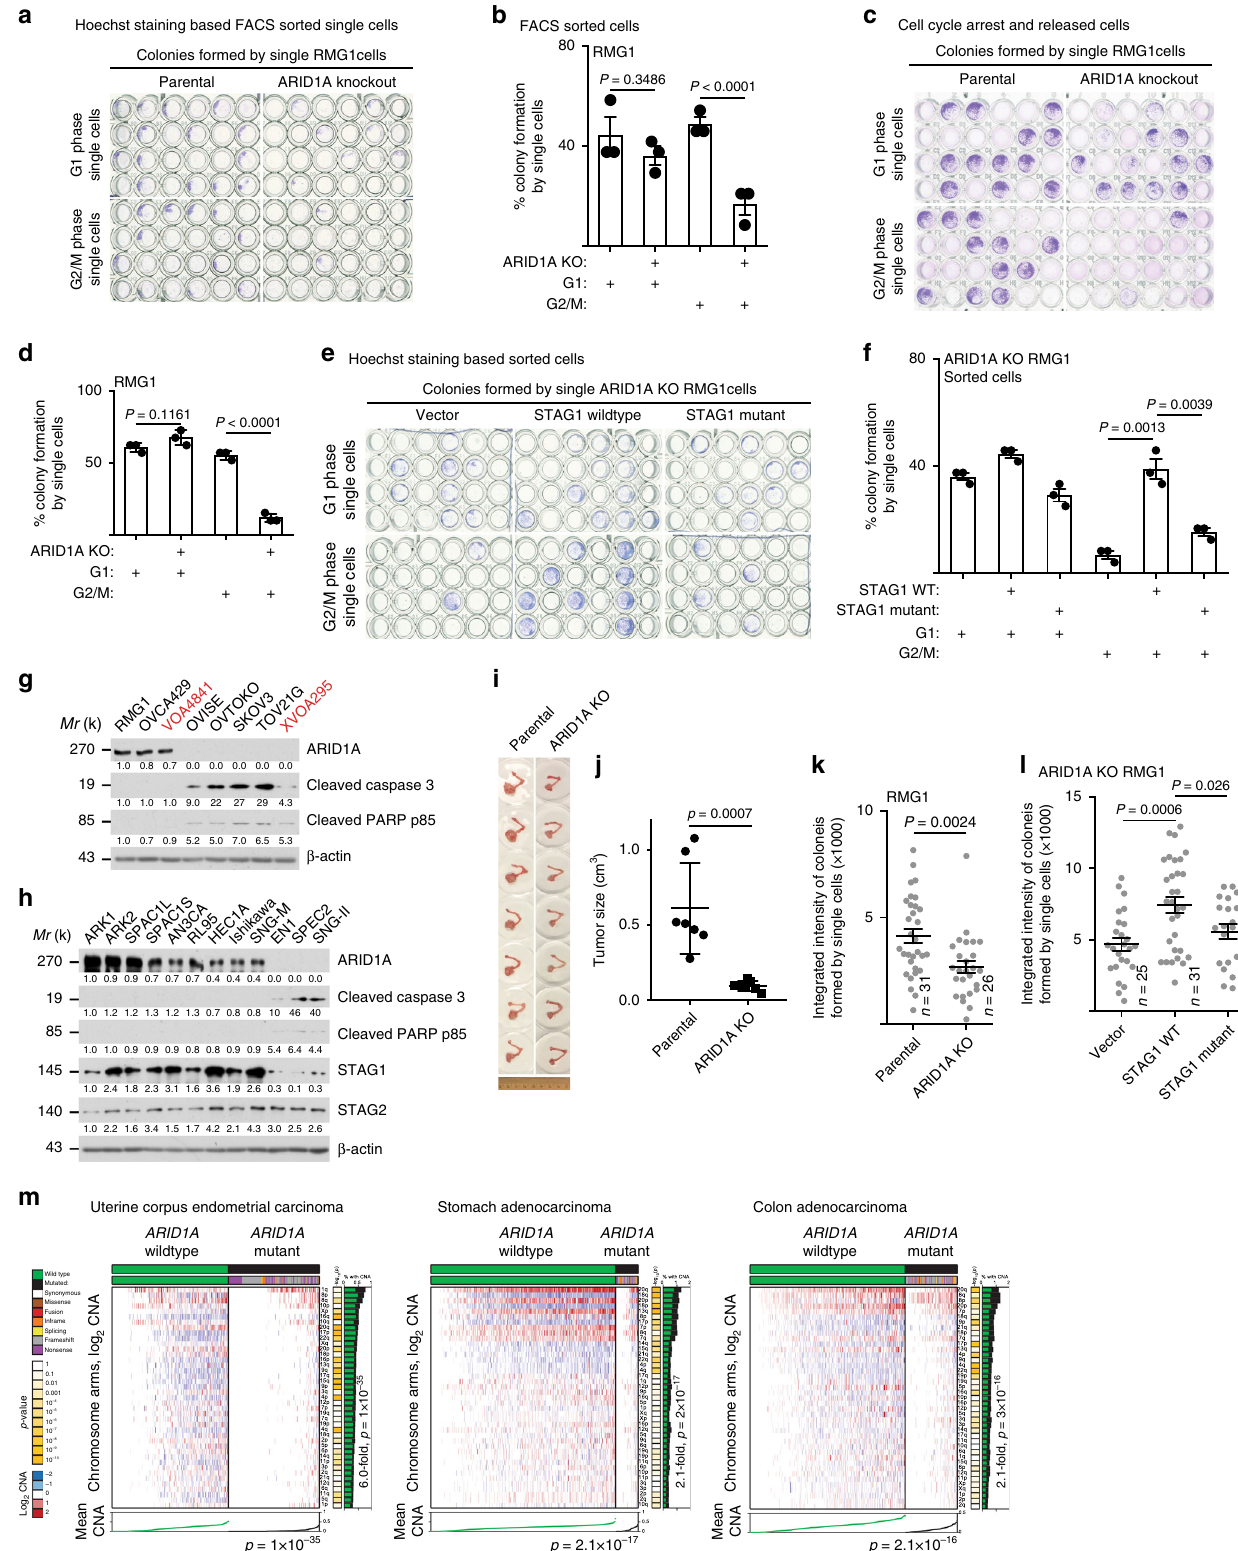
3 (Cell Signaling, Cat. No: 9661, 1:1000 for immunoblotting), mouse anti-SMC3 (Santa Cruz, Cat. No: sc-376352, 1:1000 for immunoblotting). The secondary antibodies used were raised against mouse or rabbit and conjugated with Alexa 488 (ThermoFisher, Cat. no. A-10680) or Alexa 555 (ThermoFisher, Cat. no. A-21428).